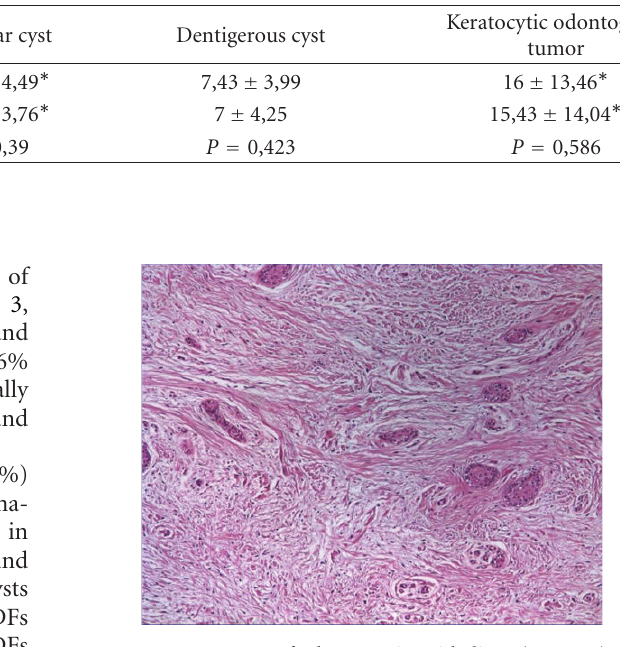
Figure 1: Rests of odontogenic epithelium (HE ×